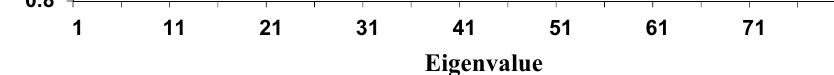
Figure 5. Total accumulated variability for xylene–toluene mixture analysis.